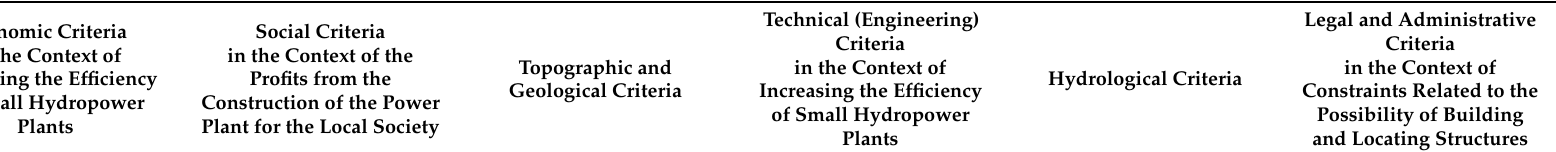
Table 1. Multi-criteria analysis of the elements essential to select the location for the construction of small hydroelectric power plants; source: own